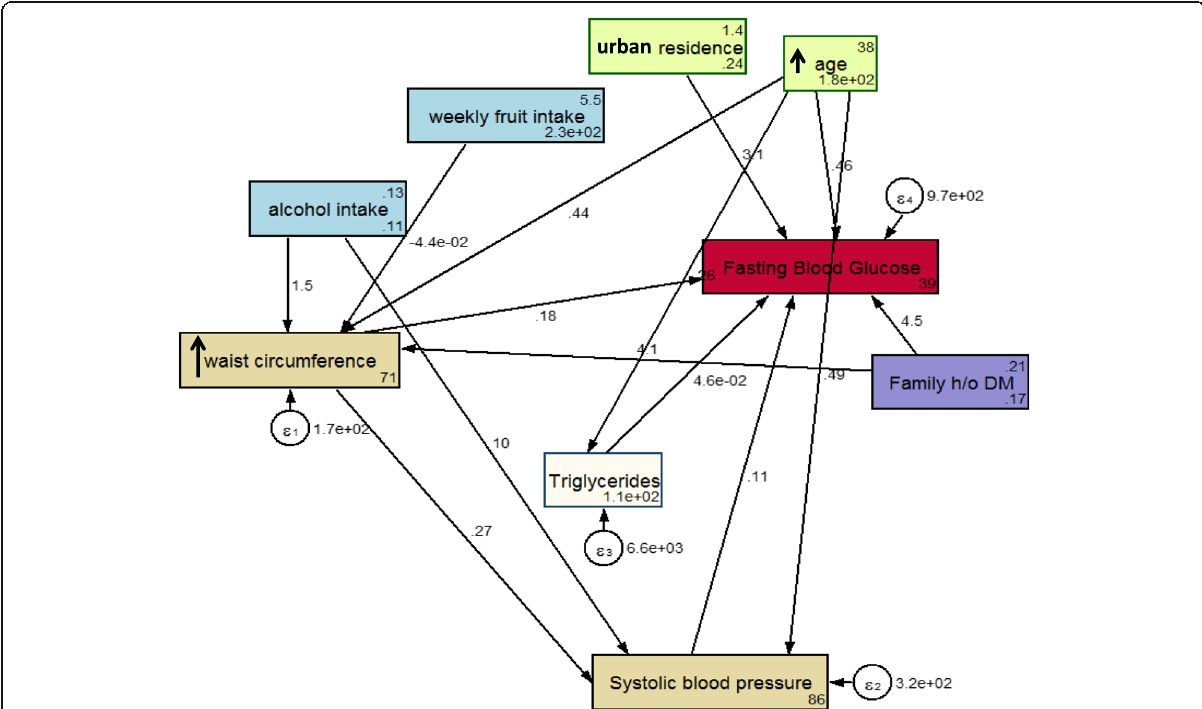
Fig. 1 SEM model of risk factors for diabetes in the STEPS survey in 2015 in Punjab, India among adults aged 18 – 69 years. Footnote: SEM=structural equation modeling; box indicates observed variable; straight line with one arrowhead denotes direct